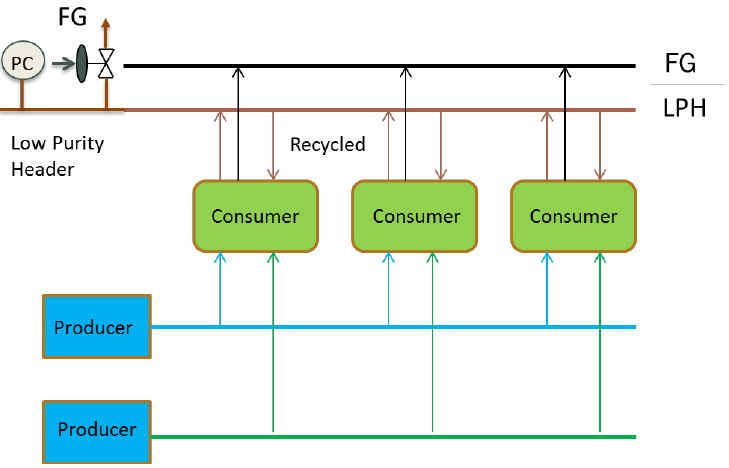
Figure 3. Schematic of producer and consumer plants with the main hydrogen distribution headers and fuel gas network.